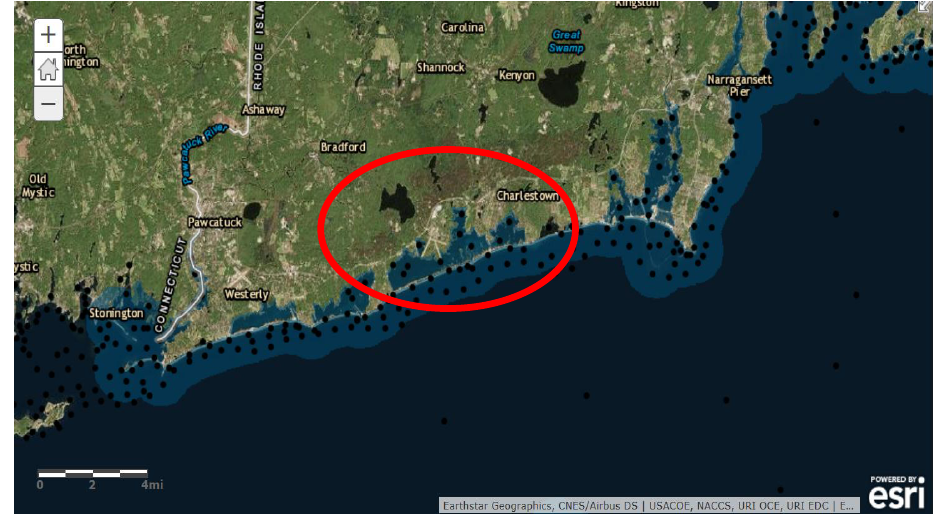
Figure 3. Location of save points along the southern RI coastline from the North Atlantic Coast Comprehensive Study (NACCS) study [8]. The location of the Charlestown study area is shown in the red